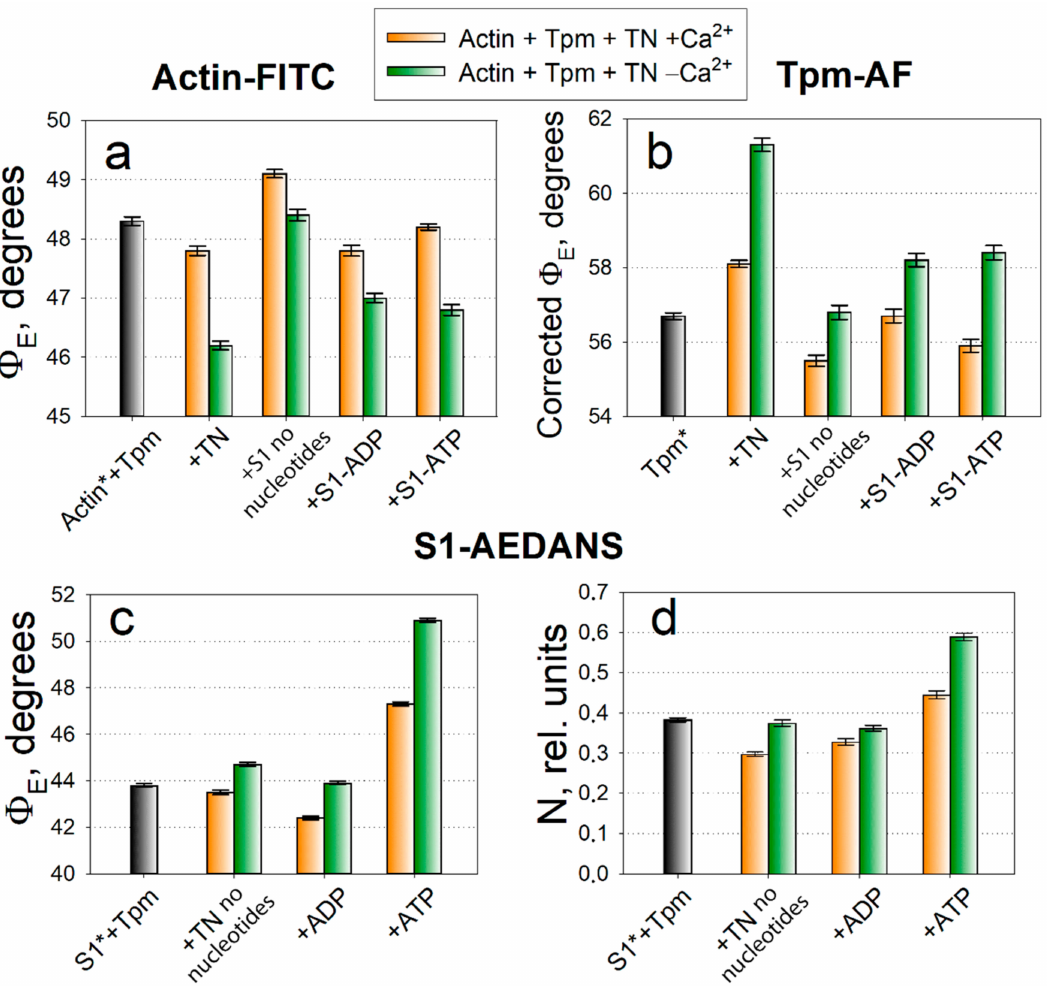
Figure 1. A typical pattern of changes in the angle of orientation of emission dipoles Φ E for fluorescent probes associated with actin (Actin-FITC, or Actin*, a ), tropomyosin (Tpm-AF, or Tpm*, b ) and in the values of Φ E and the relative number of disordered fluorophores N for probe bound to S1 (S1-AEADANS, S1*, c , d ) in ghost fibers containing reconstituted thin filaments with control recombinant Tpm (of wild type, WT) and troponin (TN). The values are compared at high (orange columns) and low (green columns) Ca 2 + concentrations. Black color is used for the values obtained in ghost fibers not containing